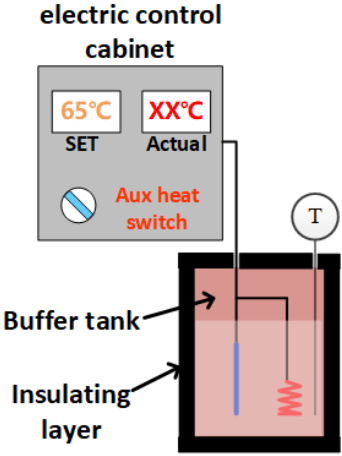
Figure 2. Buffer water tank and electric control cabinet in VMD.